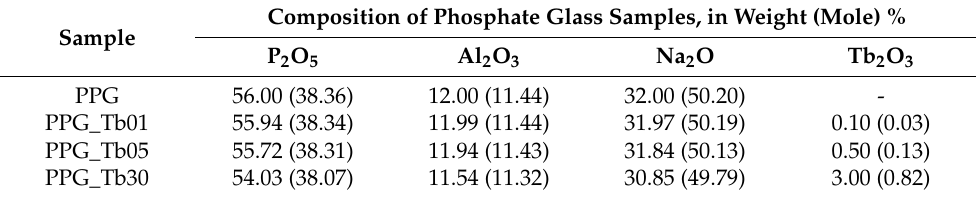
Table 1. Compositions of raw and terbium-doped phosphate glasses, in weight (mole) %.